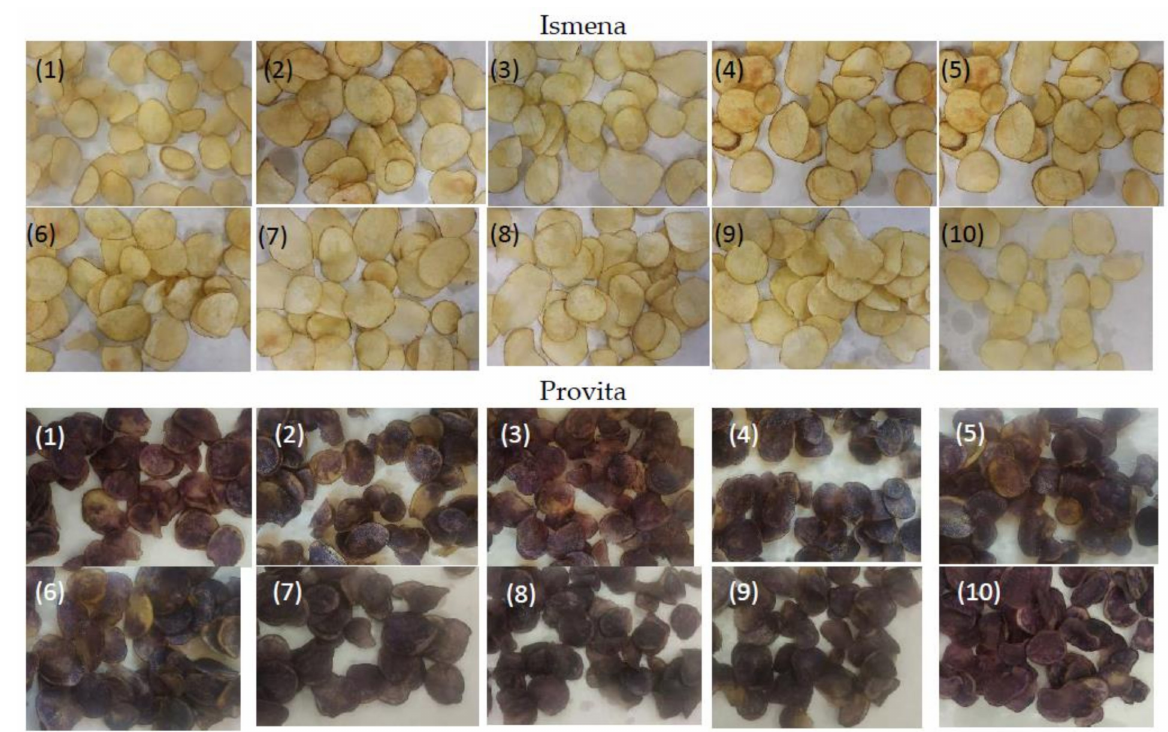
Figure 2. Potato crisps with blanching at different parameters: (1) − 80 ◦ C/2.5 min/175 ◦